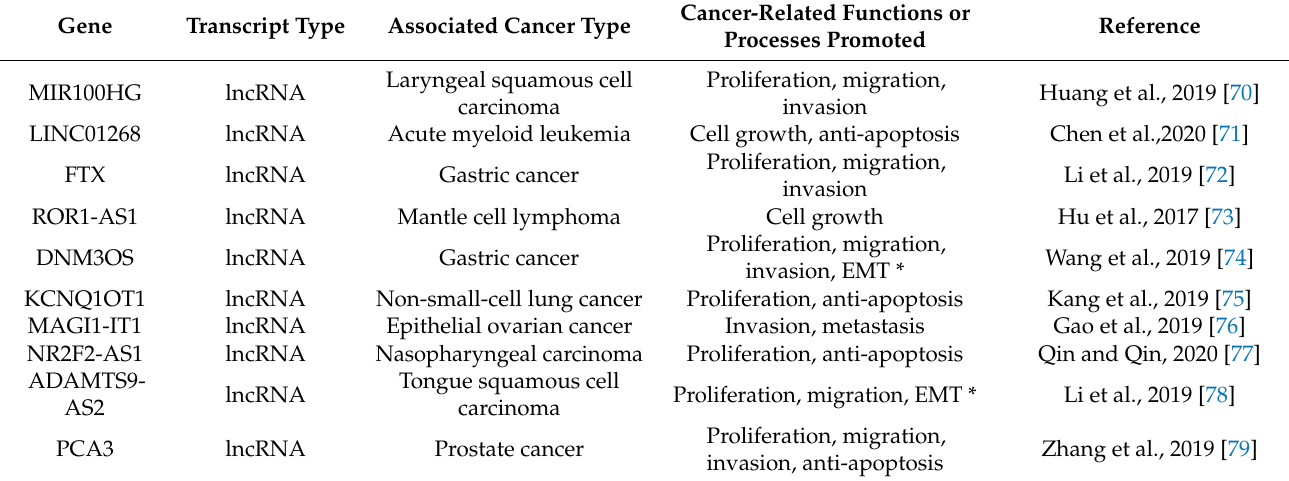
Table 3. The list of the top 10 overexpressed oncogene-candidate lncRNAs in MCL cases.